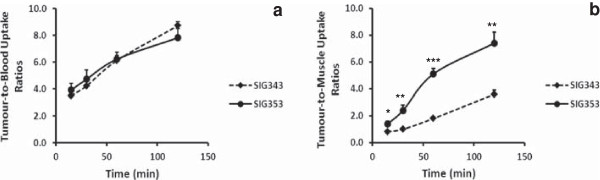
Comparisons of the tumour-to-blood (a) and tumour-to-muscle (b) uptake ratios of 18F-SIG343 and 18F-SIG353. Results were presented as the ratios of the radioconcentration (%ID/g) in the tumour and in the blood or muscle at 15, 30, 60 and 120 min. Data are derived from the biodistribution studies in A373 tumour-bearing mice (means ± SEM, n = 5). *P < 0.05, **P < 0.01, ***P < 0.001 treatment versus control (unpaired, two-tailed Student's t test).